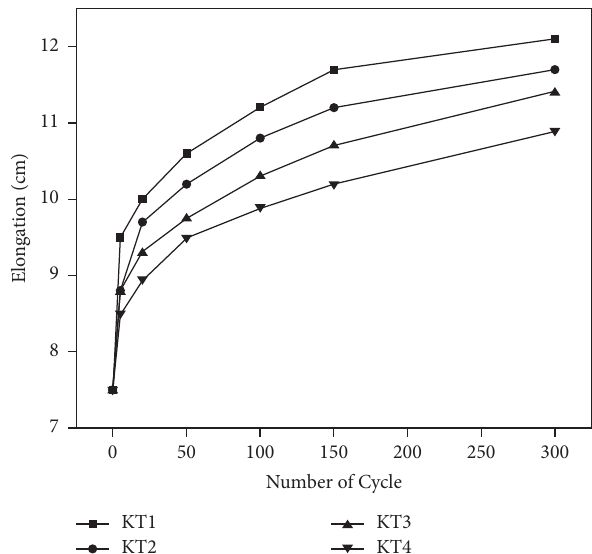
Figure 9: Elongation behavior of therapeutic tapes under 25 ° C.